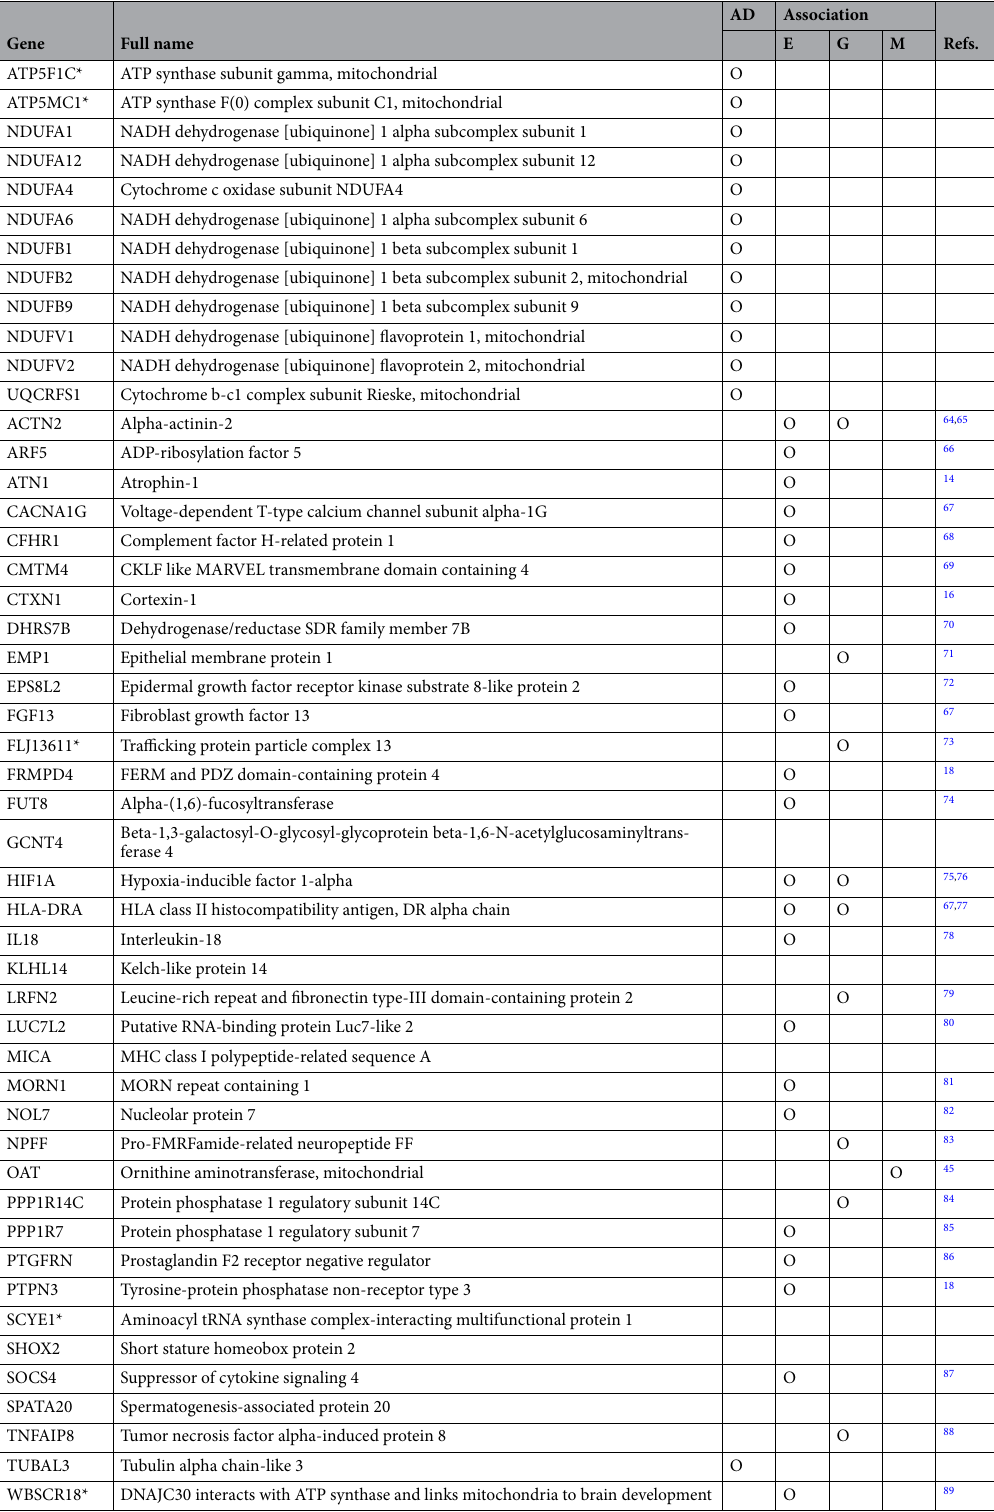
Table 3. Oxidative phosphorylation genes and their companions identified in machine learning. An “O” denotes the present knowledge that supports the involvement or association of the gene with Alzheimer’s disease. The category item “AD” indicates the involvement of the gene in the KEGG AD pathway, while “E”, “G”, and “M” indicate the evidence of association studies of the expression, genomics, and metabolomics. An * sign indicates the presence of another preferred name in the String-db. The alternative names are shown in the parentheses. ATP5F1C (ATP5C1); ATP5MC1 (ATP5G1); FLJ13611 (TRAPPC13); SCYE1 (AIMP1); WBSCR18